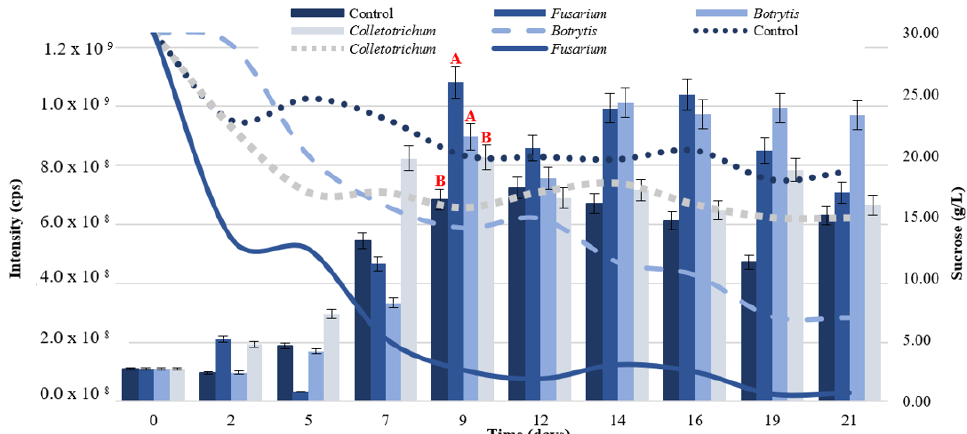
Figure 2. P aib production (bars) and sucrose consumption (lines) of T. asperellum according to the elicitor added to the culture medium. Intensity values on the left axis are relative to P aib production. Different letters represent significant differences between treatments.